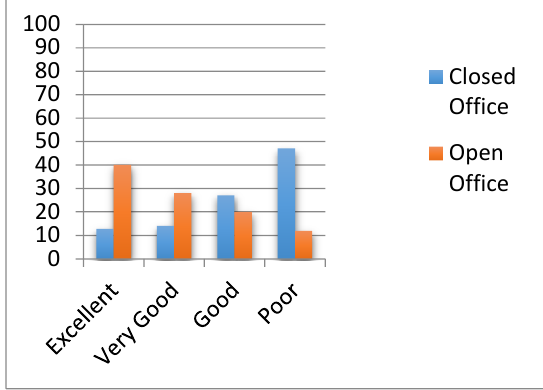
Figure 1. Satisfaction with own office Source: (Author,